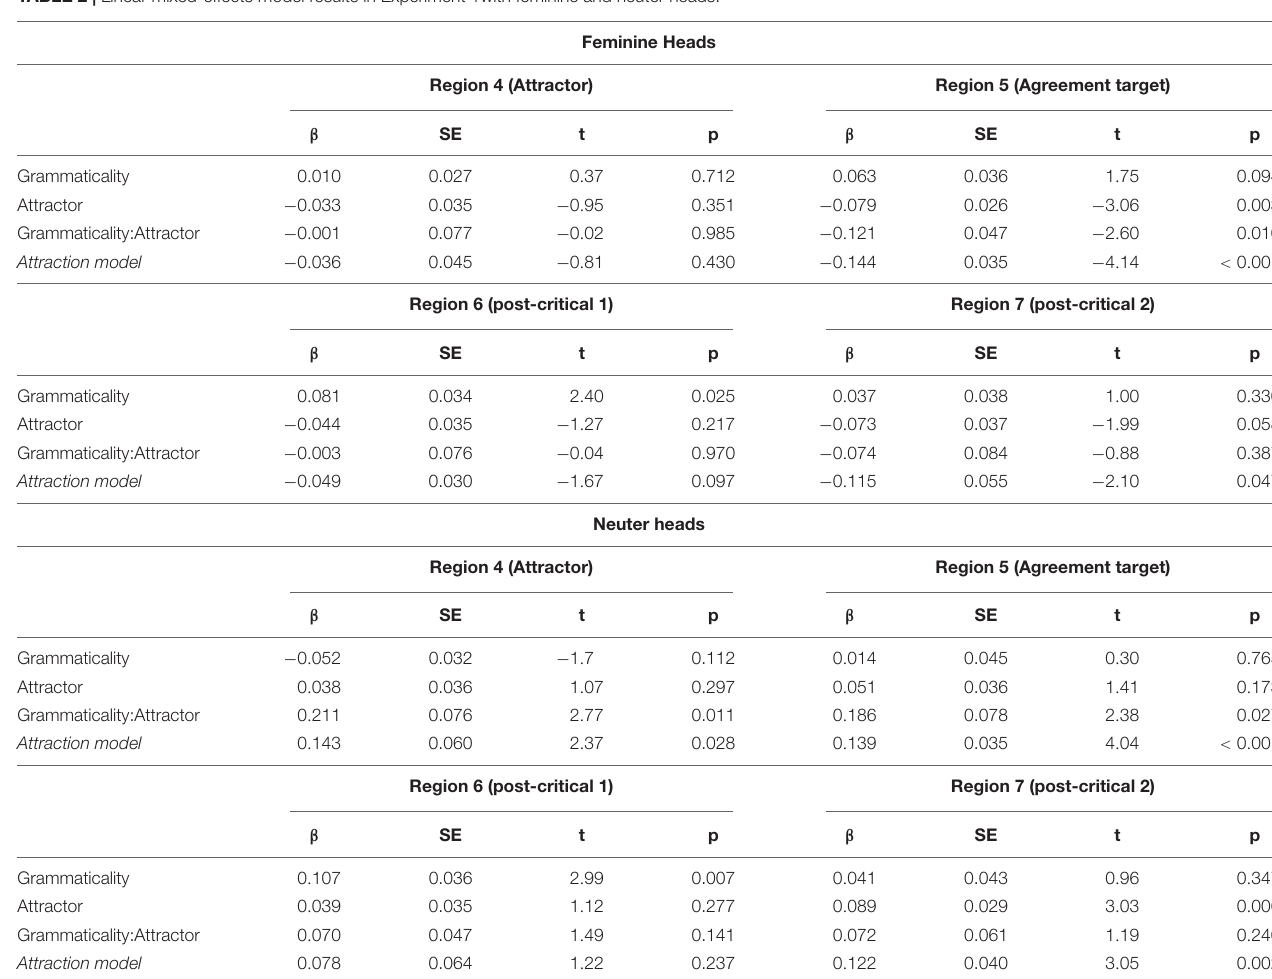
TABLE 2 | Linear mixed-effects model results in Experiment 1with feminine and neuter heads.